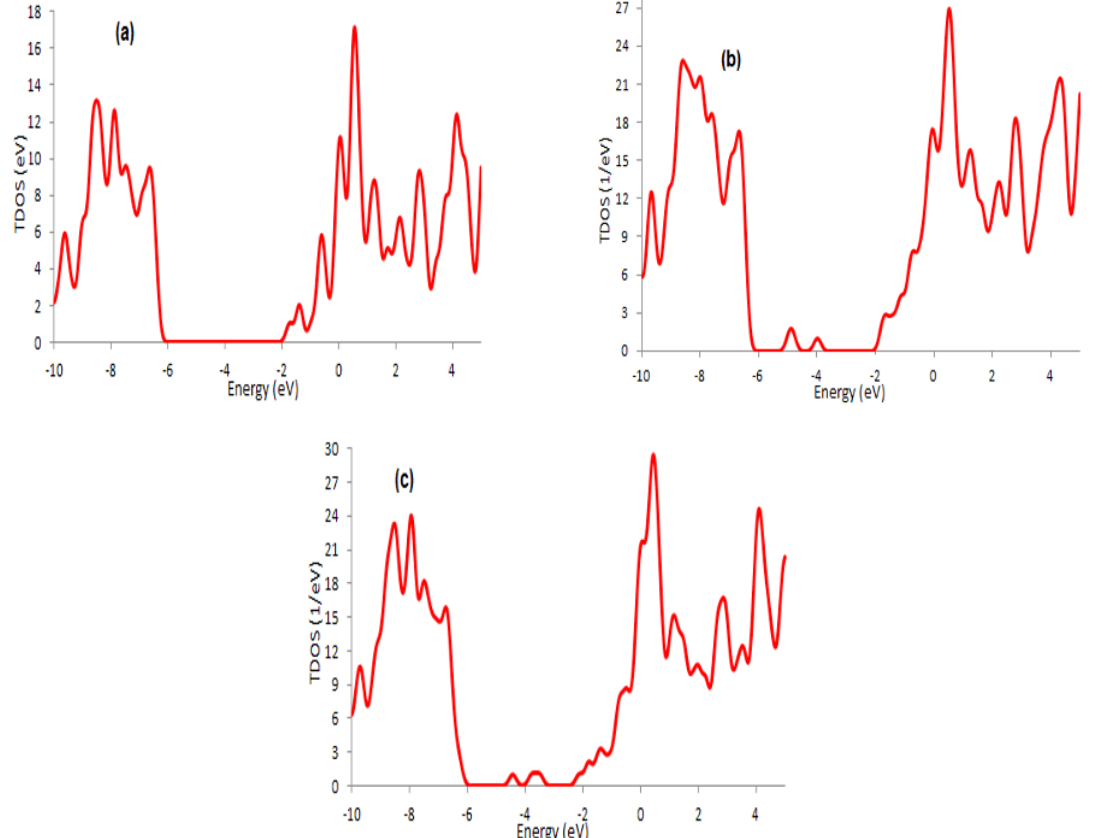
Figure 4. Curve of total electronic densities of states (TDOSs) for (a) pristine, (b) model.1 and (c) model.2 of